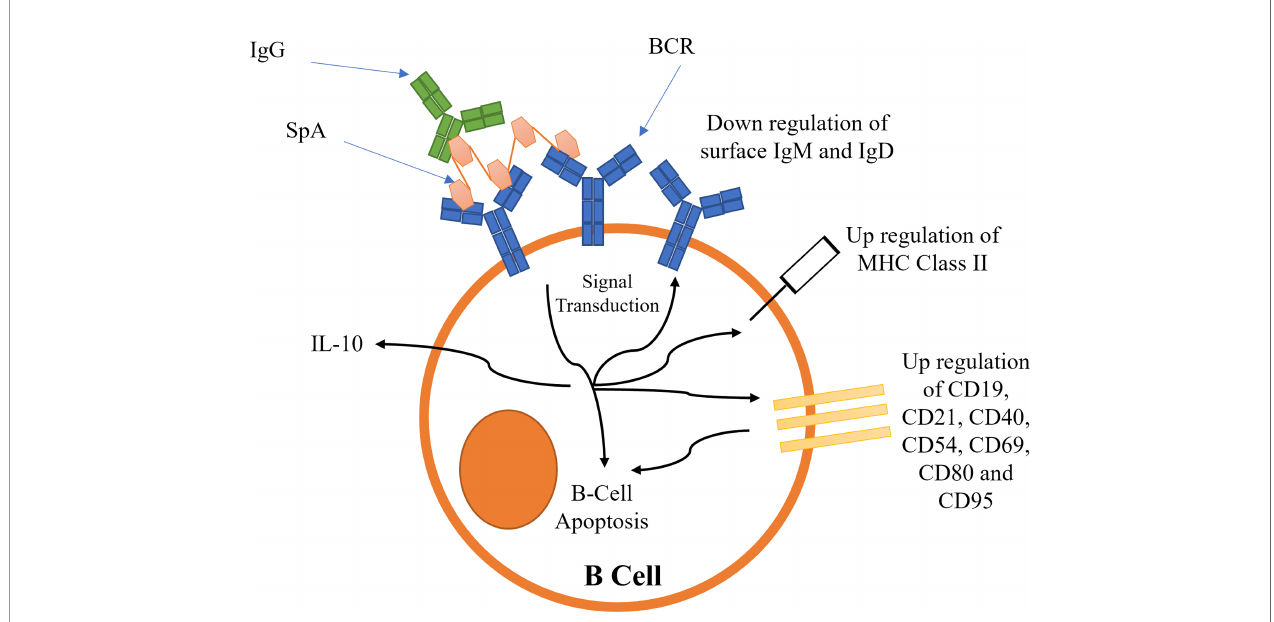
FIGURE 6 | Proposed mechanisms for the activation of B-cell receptors by SpA. Activation leads to B-cell capping and B-cell